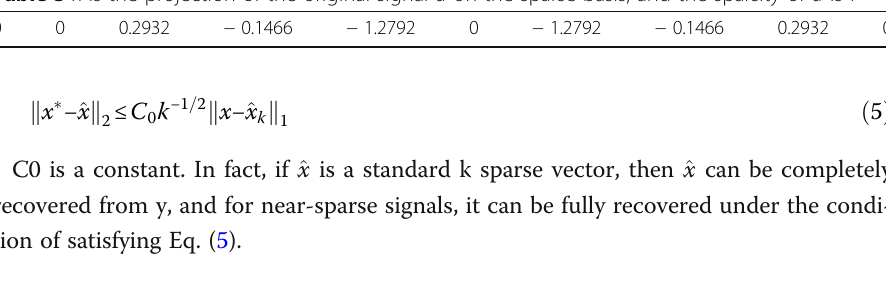
Table 5 x is the projection of the original signal u on the sparse basis, and the sparsity of u is